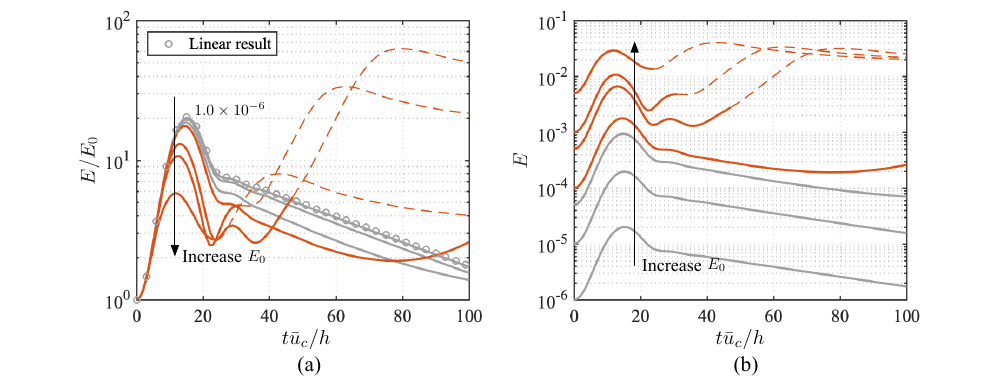
Figure 8. Time evolution of kinetic energy density E of case ( α , β ) = ( 1,0 ) initialized by different amplitudes of optimal disturbance E 0 : Red lines represent transition cases, and grey lines denote that the flow remains laminar. Dashed line indicates that the flow is in turbulent state. ( a ) Kinetic energy density normalized by its initial value E / E 0 and ( b ) kinetic energy density E